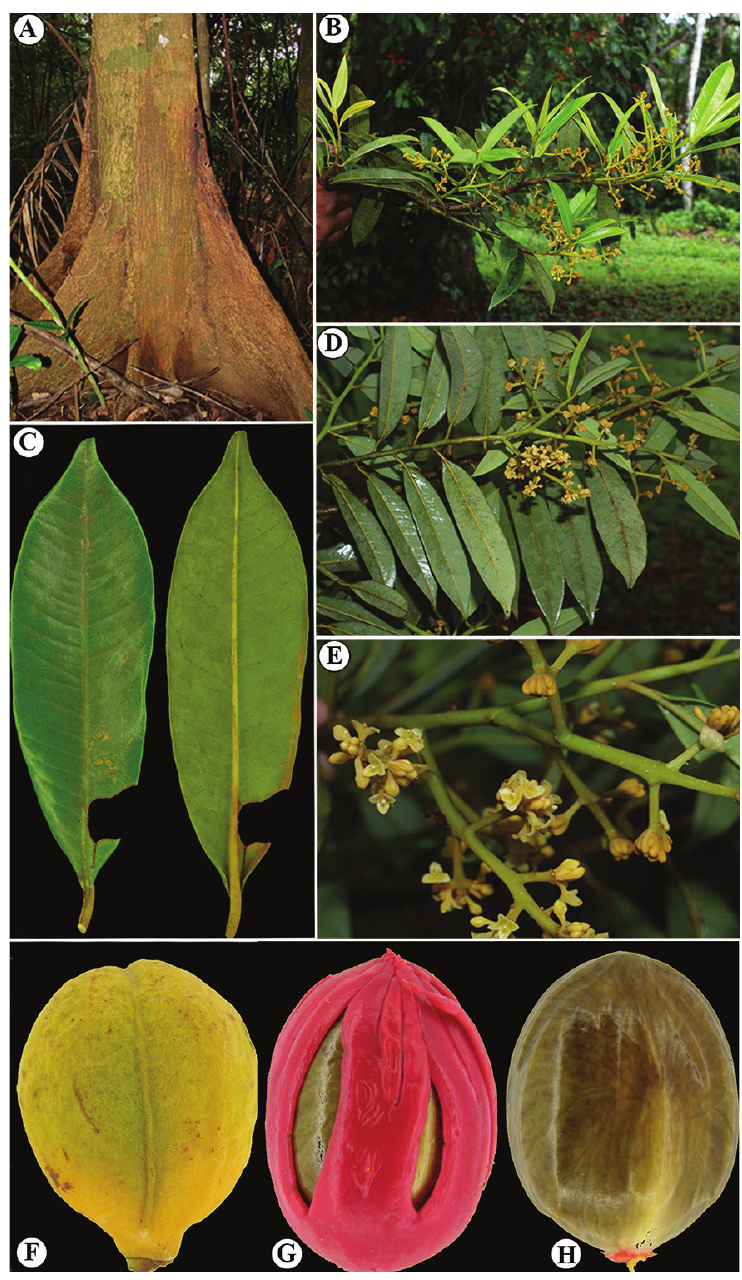
Figure 16. Virola fosteri A lower trunk and buttresses B branch with staminate inflorescences C leaf blades showing adaxial (left) and abaxial (right) surface; also demonstrating the revolute base D branch with staminate inflorescences and leaf blades on abaxial surface E close up of staminate inflorescences F fruit G aril covering the seed H seed Photos by Rolando Pérez ( A ), Carmen Galdames ( B, D, E ), Steven Paton ( C, F, G, H ); all photos from